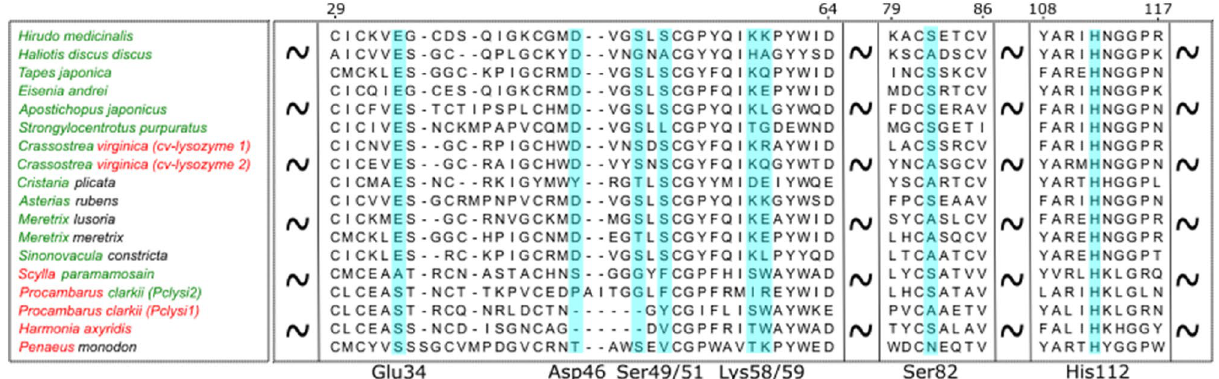
Figure 2. Multiple sequence alignment of destabilase homologs with confirmed muramidase and/or isopeptidase activities from Table 1. Color of the first half of the organism taxonomy name corresponds to the muramidase activity and the second half—to the isopeptidase activity. Green and red colors mean presence and absence of the confirmed corresponding activity, black means no information is available related to corresponding activity. Amino acids discussed in the manuscript are marked with light